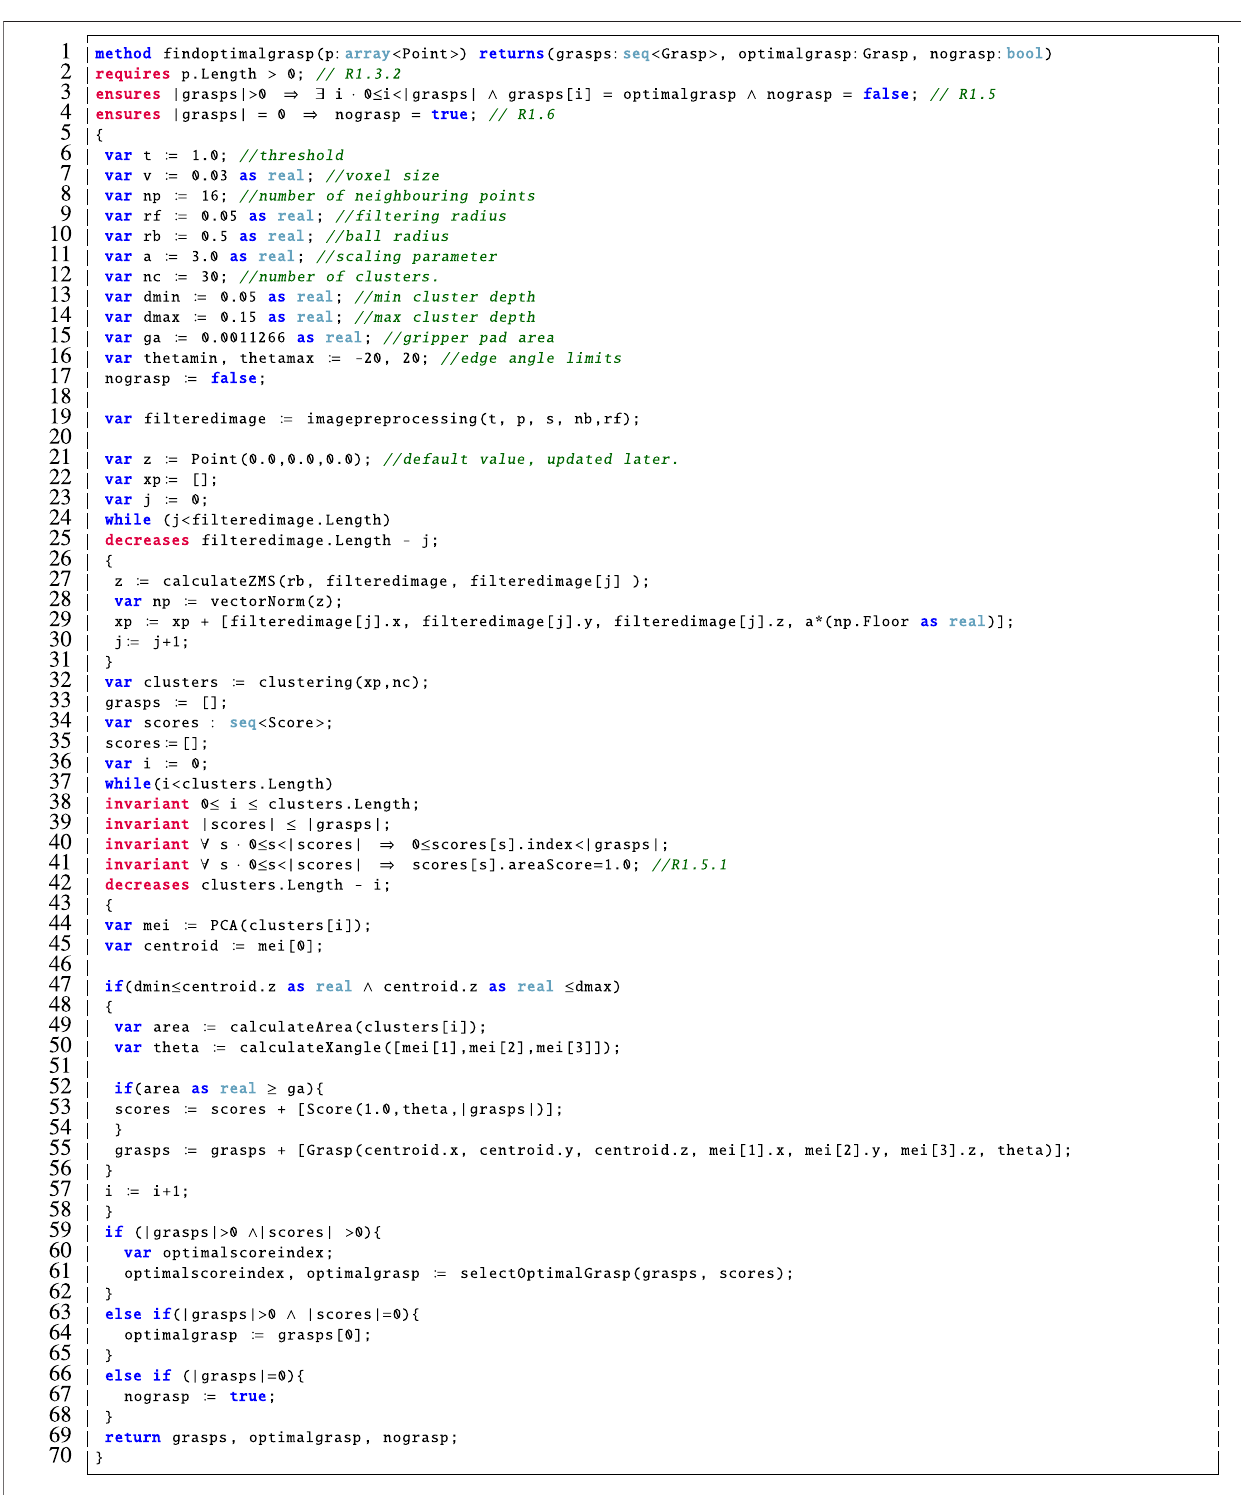
FIGURE 8 | Dafny encoding of the fi ndoptimalgrasp method.